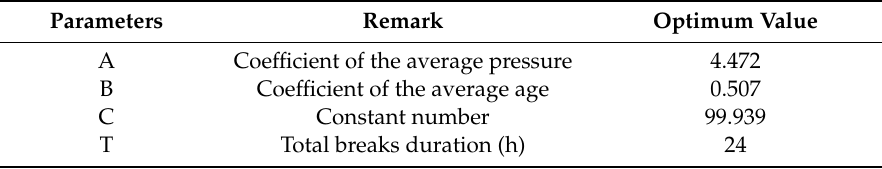
Figure 7. Calibration process: ( a ) Changes of the objective function during 500 iterations; ( b ) Observed and simulated leakage during the optimization process (2007–2016). Table 2. Optimum values obtained at the end of the calibration process.